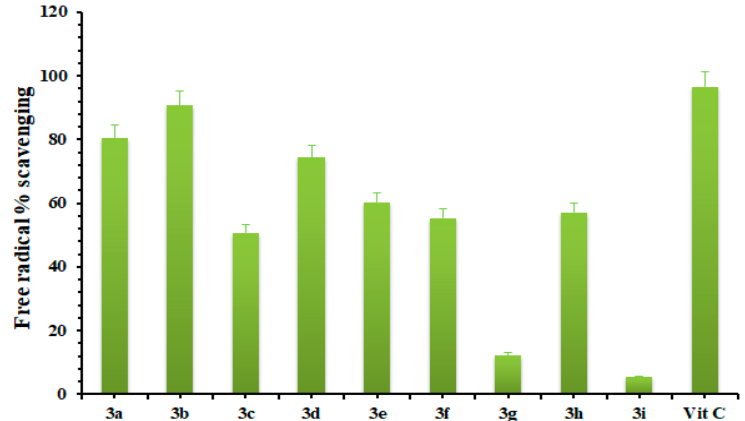
Figure 3. The percentage of free radical scavenging activities of the synthetic compounds presented as the mean ± SEM. All of the compounds were tested at a concentration of 100 µg/mL.